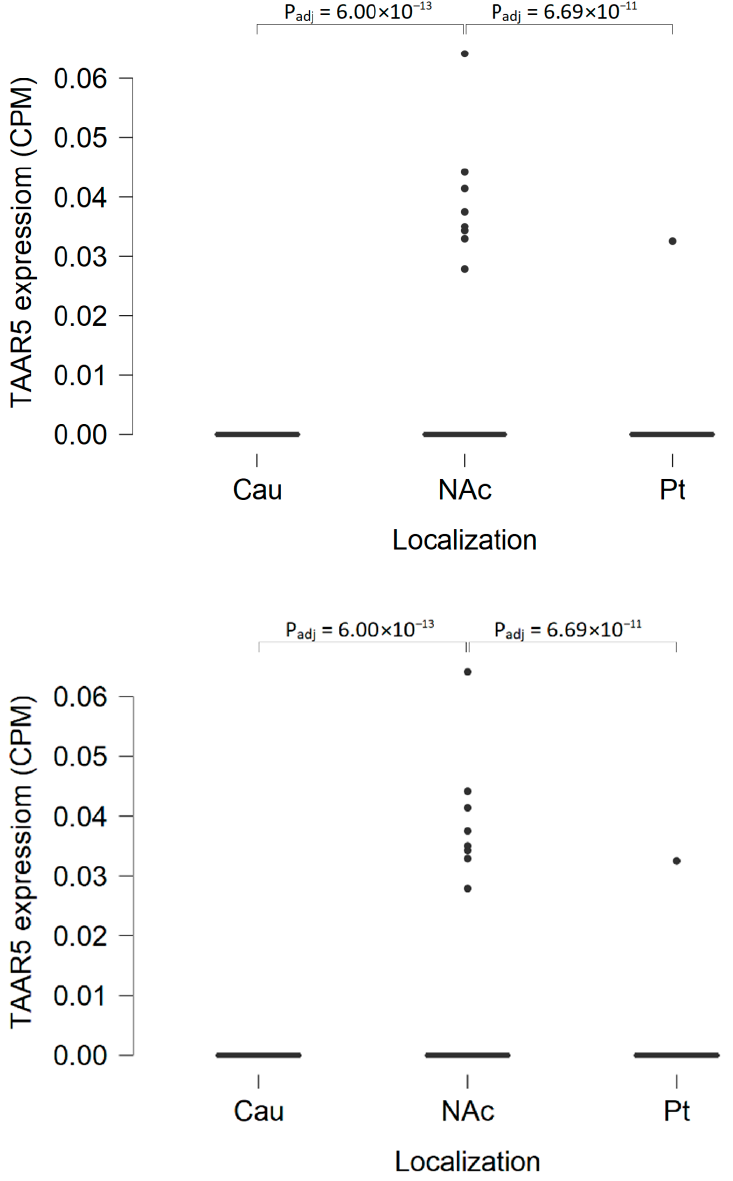
Figure 3. TAAR5 expression in the basal nuclei of healthy humans. TAAR5 expression in nucleus accumbens is significantly more pronounced compared to its expression in the caudate nucleus or putamen (GSE160521, caudate nucleus, n = 59; nucleus accumbens, n = 59; putamen, n = 59); Cau—caudate nucleus, NAc—nucleus accumbens, Pt—putamen.